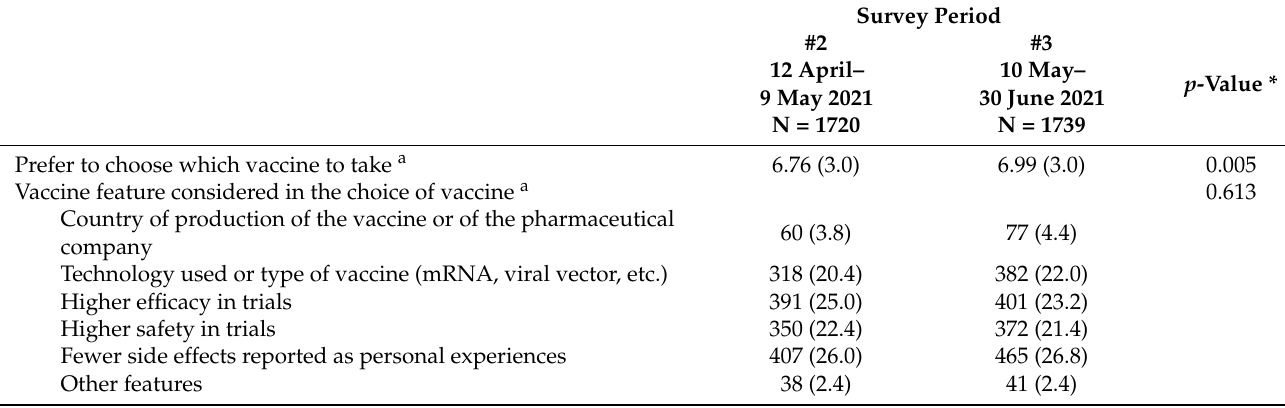
Figure 1. Prevalence of vaccine hesitancy ( A ), mean confidence in vaccine safety ( B ) and effectiveness ( C ) among the students surveyed from March 1st and 12 March 2021 (first period, purple line), from 12 April to 9 May 2021 (second period, blue line) and from 10 May to 30 June 2021 (third period, orange line) at Sapienza University of Rome. Table 3. Students’ attitudes towards vaccination against SARS-CoV-2 by survey period (optional questions added to the questionnaire from 12 April 2021). Results are expressed as mean (standard deviation) or frequency (percentage).